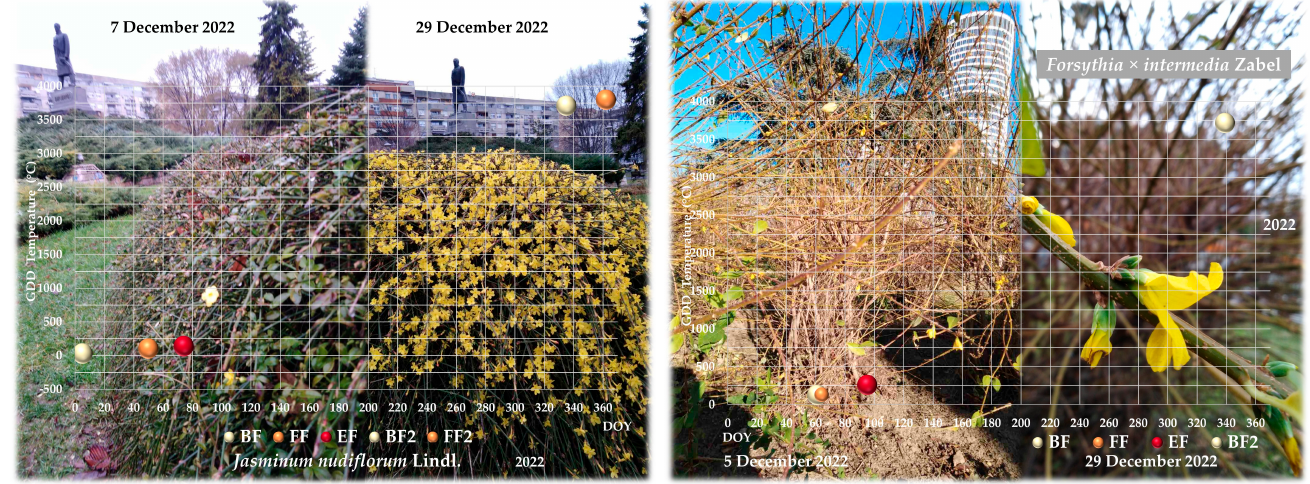
Figure 9. Phenological observations: GDD and DOY for the start of first bloom (BF), full first bloom (FF), the end of first bloom (EF), the start of second bloom (BF2), and full second bloom (FF2) for Weeping Winter Jasmine (left) and Border Forsythia (right) in 2022.